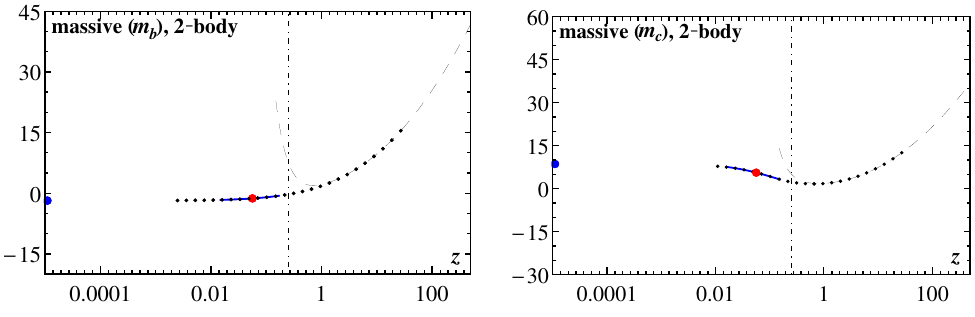
from diagrams with closed loops of massive fermions | see 27